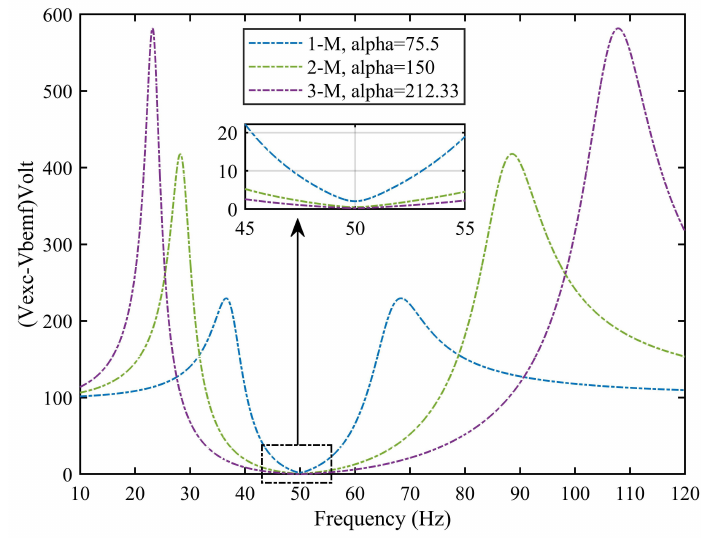
Figure 18. Difference between applied voltage and back emf for all modules. The response of TMM-LOA in terms of input current taking one, two, and all three modules at different values of operating frequency in Figure 19 by dotted lines. As the thrust force is the product of input current and motor constant, the response of TMM-LOA in terms of thrust force at different operating frequencies is therefore shown in Figure 19 by solid lines for the single, two, and three modules.